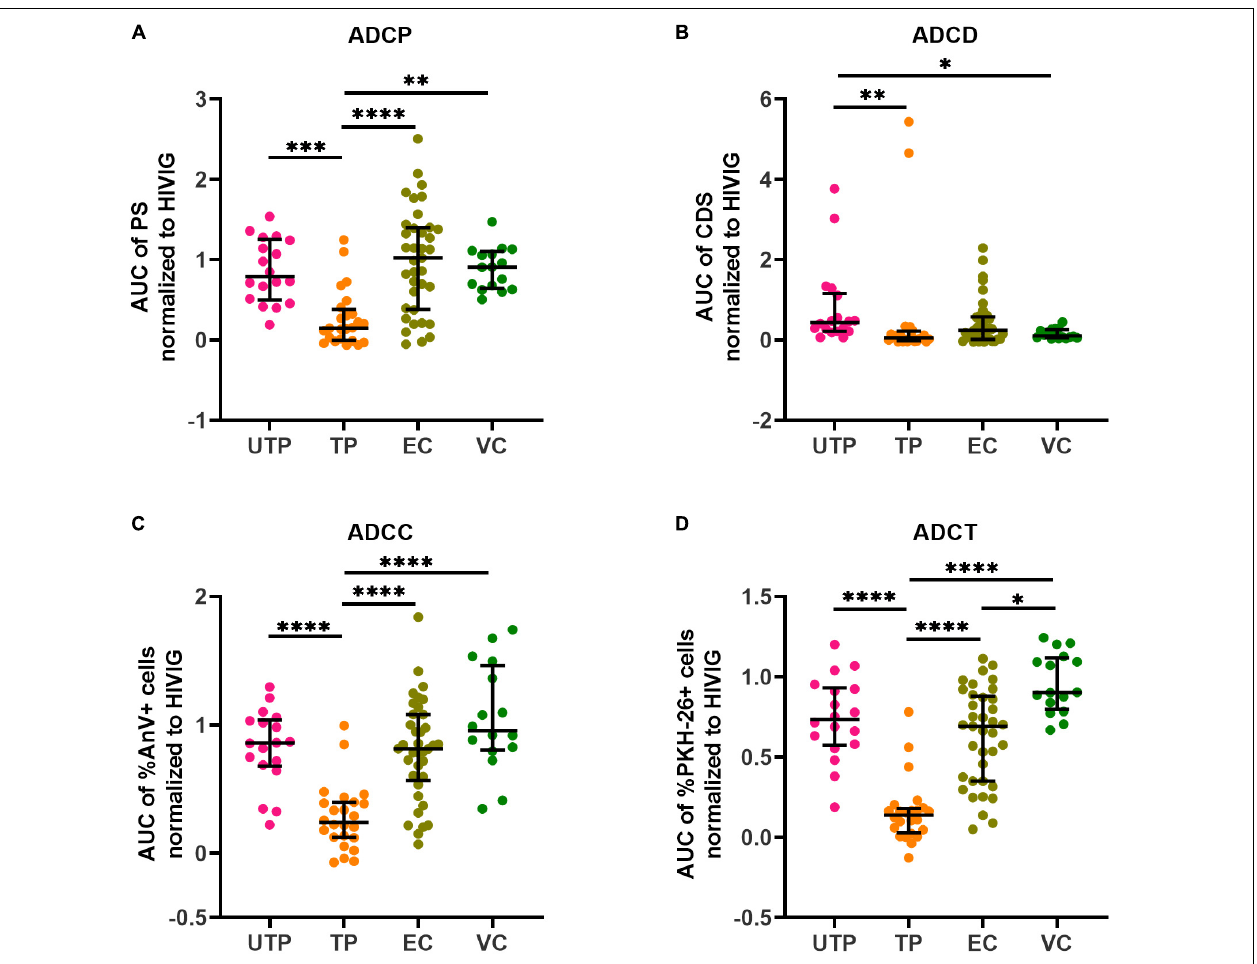
FIGURE 2 | Quantification of Ab-dependent (AD) functions in HIV + plasma. HIV + plasma from UTPs, TPs, ECs and VCs were tested for (A) AD cellular phagocytosis (ADCP), (B) AD complement deposition (ADCD), (C) AD cellular cytotoxicity (ADCC), and (D) AD cellular trogocytosis (ADCT) as described in the methods. Each point represents results generated by the plasma of a single individual. Lines and error bars though each data set represent medians and IQRs. Data from 18 UTPs, 24 TPs, 37 ECs and 16 VC are used to prepare these four panels. Kruskal–Wallis tests with Dunn’s multiple comparisons post test were used to assess the significance of between-group differences. ∗ p < 0.05, ∗∗ p < 0.01, ∗∗∗ p < 0.001, ∗∗∗∗ p < 0.0001. All results shown were background subtracted and were normalized to the concentrations of internal HIVIG positive controls tested at the same time as test samples. AUC, partial area under the curve; PS, phagocytic score; CDS, complement deposition score; %AnV + cells, frequency of AnnexinV + siCEM cells; %PKH-26 + cells, frequency of PKH-26 +